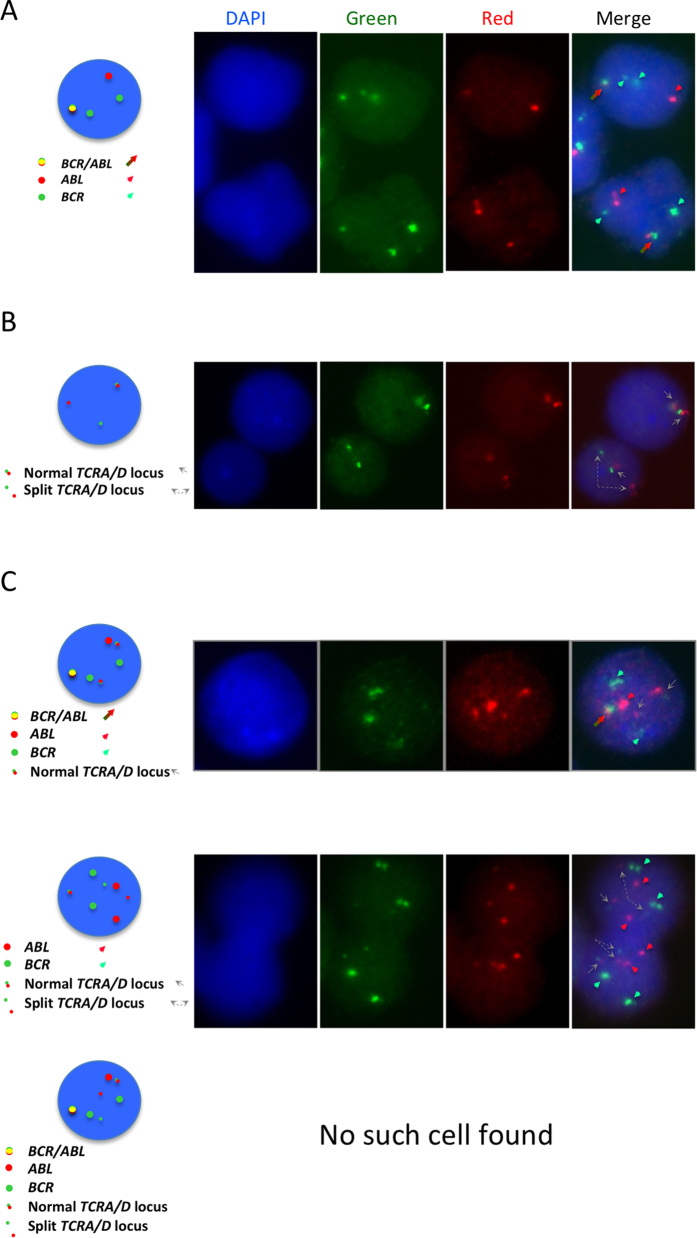
FISH characterisation of diagnostic CML and PTCL samples using the commercial probes that recognise the BCR/ABL fusion or the TCRA/D split.(A) Ideogram and a typical example of the pattern observed in pathological nuclei hybridised with the Vysis LSI BCR/ABL DC/DF probe showing one fusion, two green and one red signals corresponding to the loss of the reciprocal ABL locus. (B) Ideogram and a typical example of the pattern seen in lymphoma cells the bear the t(X;14) detected as split in the TCRA/D locus. A normal cell with intact 14q locus as testified by the vicinity of the red and green signals and an abnormal cell in which one of the two red/green pairs is separated due to the 14q break are shown. (C) Experiments performed combining the two probes. Big red signal corresponds to the ABL locus, the big green one to the BCR locus, whist the little red and green hybridisation spots correspond to the TCRA/D locus. Ideograms and examples of hybridisation are shown as well as an ideogram of an inexistent cell bearing both translocations.